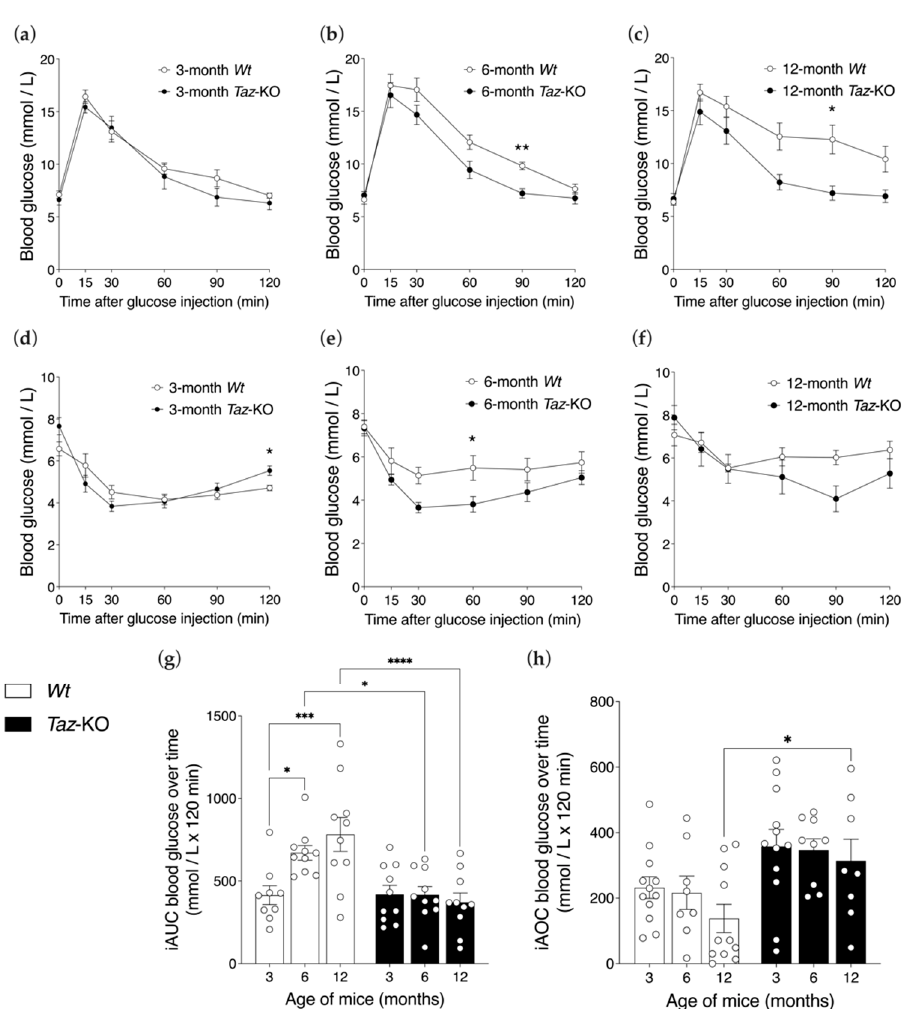
Figure 7. Taz -KO mice are protected from age-related impairments in glucose control. Glucose tolerance testing (GTT) ( a – c ) and insulin tolerance testing (ITT) ( d – f ) were performed in three age cohorts of mice. Significant differences in glycemia across timepoints during GTT or ITT were assessed by repeated-measures two-way ANOVA followed by Bonferroni’s multiple comparisons tests. * p < 0.05, ** p < 0.01. Corresponding average incremental area-under-the-curve (iAUC) for GTT ( g ) and incremental area-over-the-curve (iAOC) for ITT ( h ) are shown. Statistical analysis was performed using two-way ANOVA followed by Bonferroni’s multiple comparisons tests. * p < 0.05, *** p < 0.001, **** p < 0.0001. Data are means ± SEM ( n = 9–12).